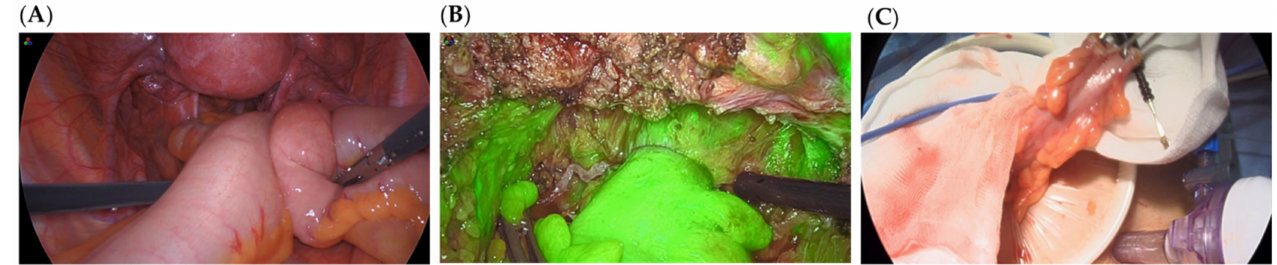
Figure 1. Exemplification of frame categories used to create the database. The intestinal tract in healthy conditions—in this case—or with deep infiltrating nodules ( A ). The bowel after segmental resection—in this case—or discoid excision with ICG ( B ). The proximal part of the bowel outside the peritoneal cavity after a segmental resection ( C